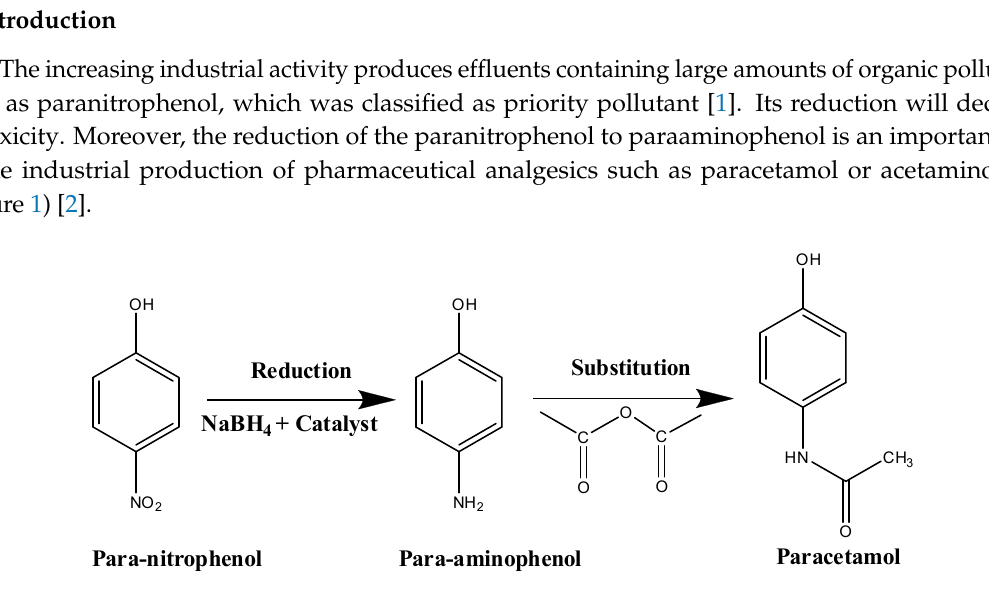
Figure 1. Schematic synthesis of the paracetamol from paranitrophenol.